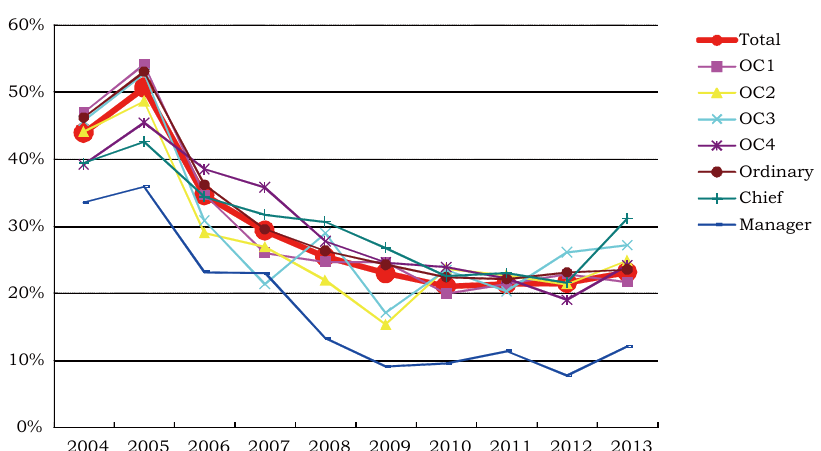
Figure 2. Annual transitions in turnover candidate ratio of Survey